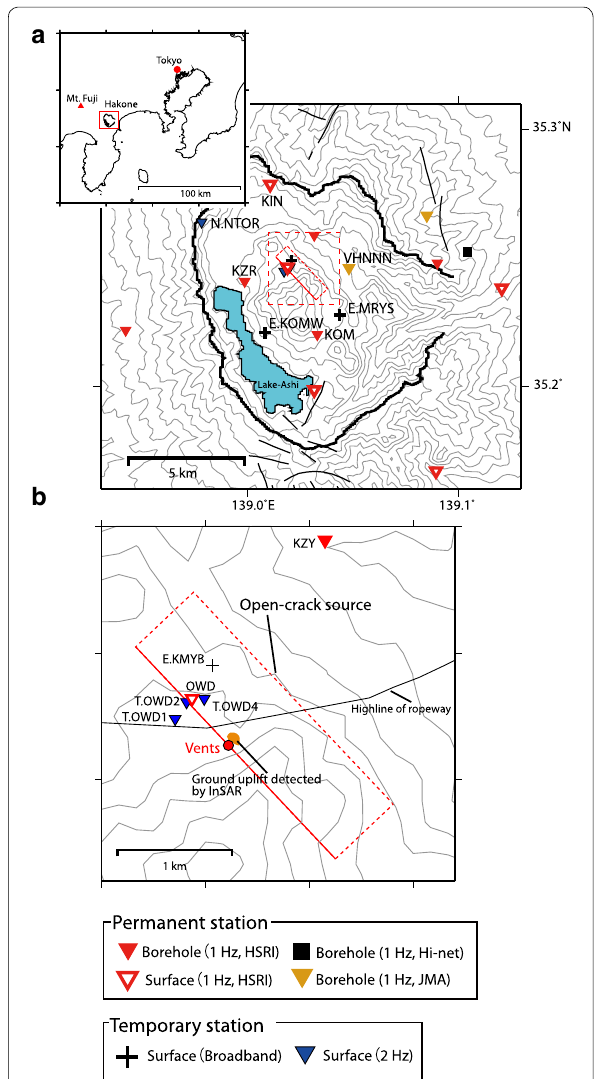
Fig. 1 Maps of Hakone volcano. a Distribution of seismic stations in and around the caldera. The study location is indicated by the red rectangle in the inset map. The bold line indicates the rim of the caldera. Gray lines show the detailed topography of Hakone volcano. b Magnified map of the area around the Owakudani geothermal region. The red dot indicates the location of the vents that formed during the phreatic eruption (Mannen et al. 2015). The orange region indicates the area of ground uplift detected by SAR interferometry that started 2 months before the eruption (Doke et al. 2015). The red rectangle indicates the location of the open-crack source oriented NW–SE that was estimated by the tilt change (Honda et al.